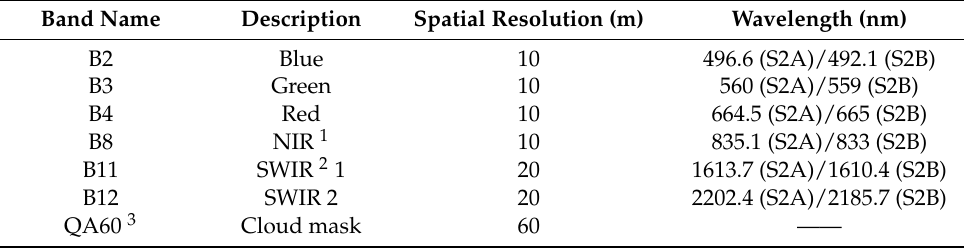
Table 1. Specification of Sentinel-2 bands used in this